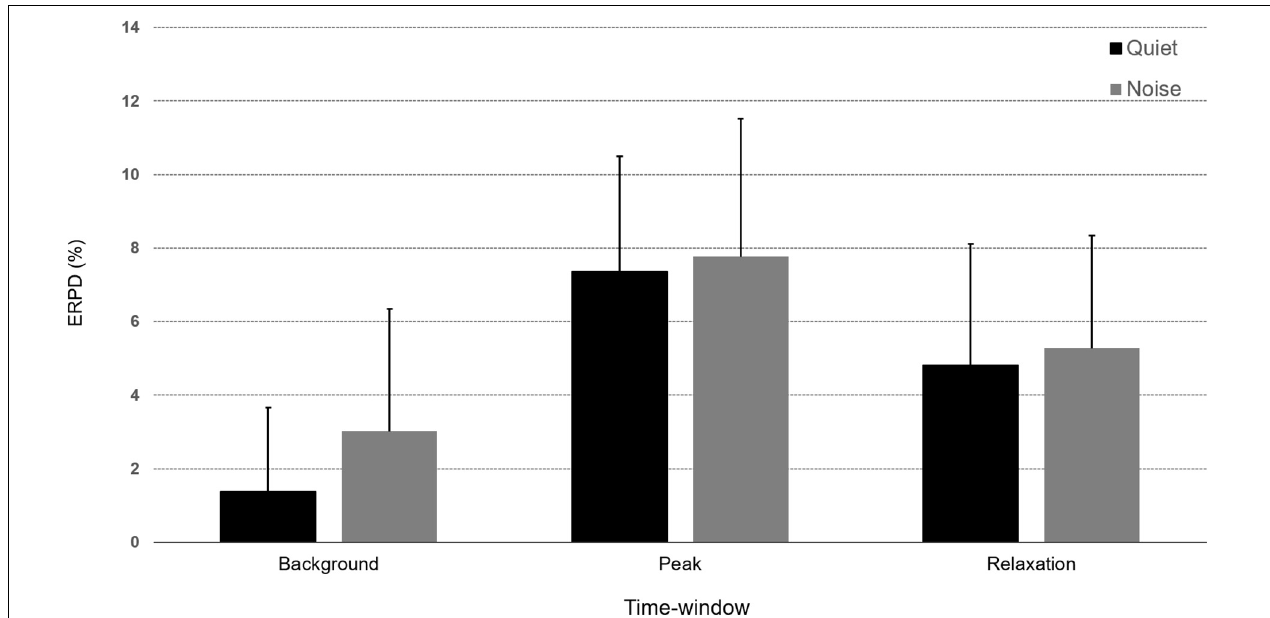
FIGURE 4 | Bar-graphs representing percent change in event-related pupil dilation (ERPD) averaged over the three time-windows (Background, Peak, and Retention interval) for correct words presented in the Quiet (black) or Noise (gray) conditions. Error bars represent standard deviation of the mean.